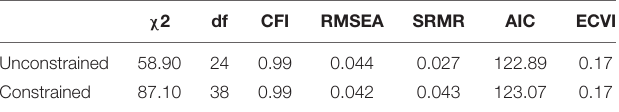
TABLE 3 | Unconstrained and constrained structural paths across